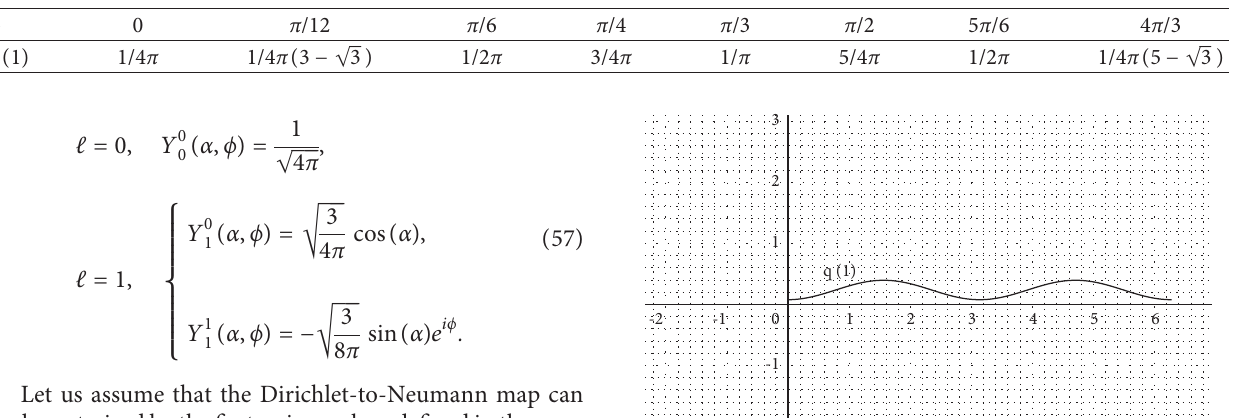
Table 1: Some values of the potential near the edge.